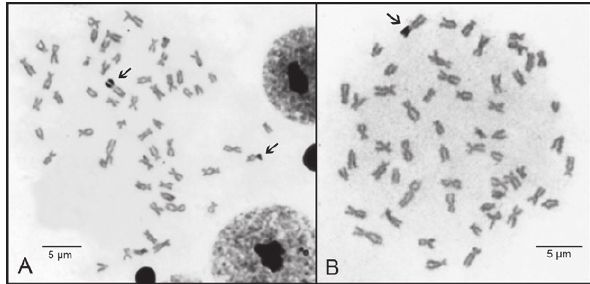
Figure 2. Metaphases of the hybrid “cachandiá” after Ag-NOR staining. In (A), a metaphase presenting two chromosomes of dif- ferent sizes with Ag-NORs and (B) a metaphase with nucleolar dominance and only one Ag-NOR. Arrows indicates the NOR- bearing chromosomes.